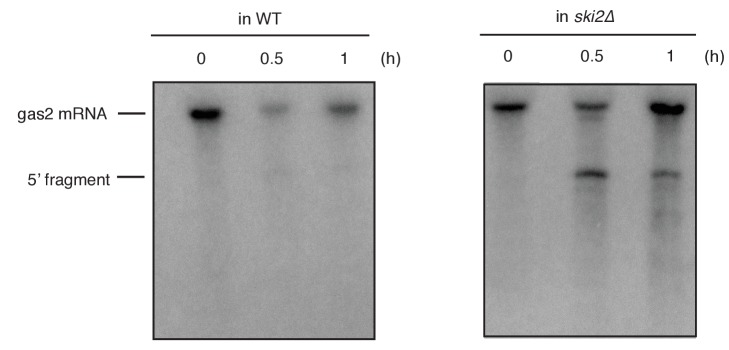
Northern blot analysis of total RNA extracted from wild type (WT) and ski2Δ mutant cells.A time course after UPR induction by addition of the ER stress inducer DTT (2 mM) is shown. Cells contained an integrated reporter construct that contained the coding sequence of the RIDD substrate gas2 under the control of the nda2 (encoding tubulin) promoter and the 3’ untranslated region (UTR) of nda2. A probe complementary to the 5’ UTR of the gas2 reporter was used to detect cleavage products.